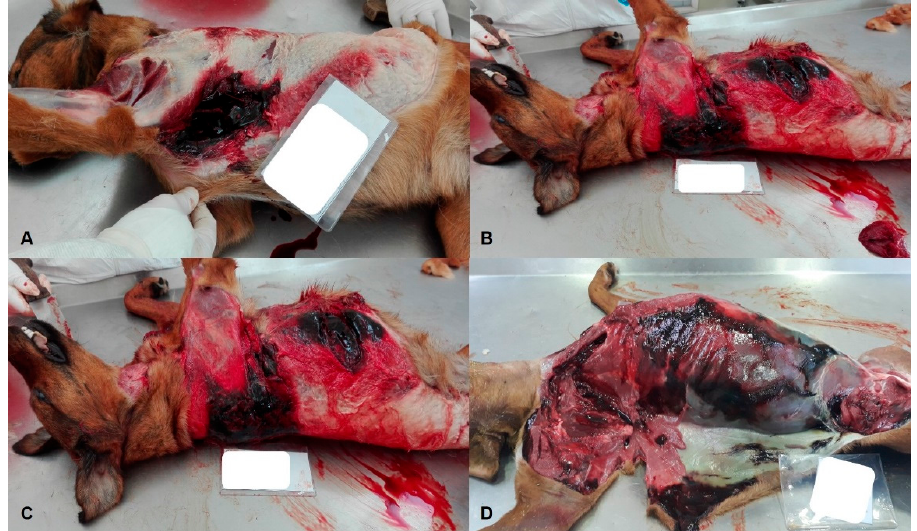
Figure 3. ( A – D ): Other injuries of blunt force trauma in dogs. Adult, medium-sized, crossbred female dog, presenting fractures of the right femur, subcutaneous sero-bloody infiltrations, with muscle haemorrhages, rib fractures, petechiae and subcutaneous suffusions in the neck and chest, and subcutaneous haemorrhagic infiltrations in the right